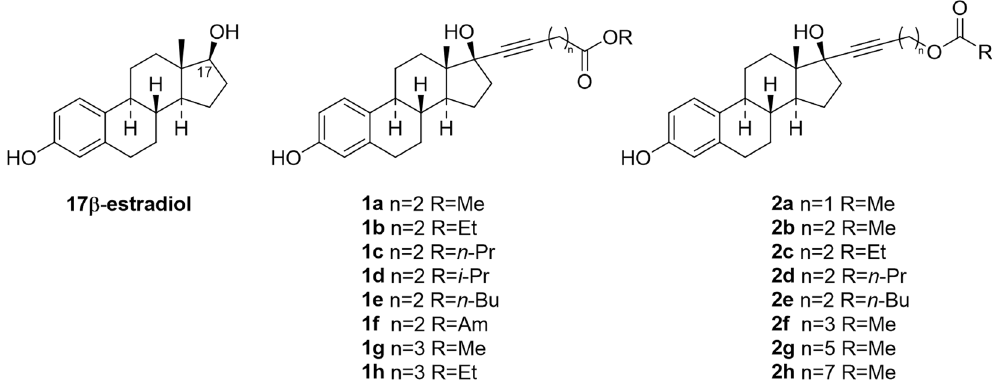
Figure 1. Chemical structures of 17 β -estradiol and derivatives 1 and 2.